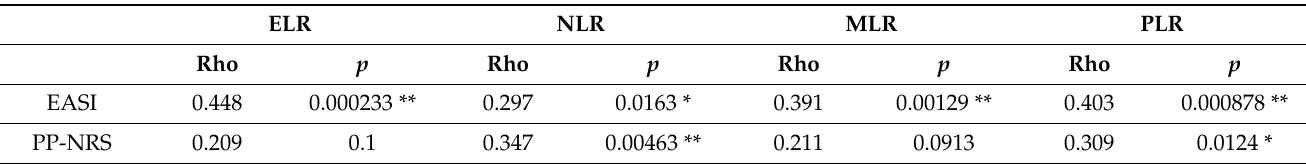
Table 2. Correlation between baseline values of laboratory parameters versus those of clinical indexes in patients with atopic dermatitis ( n =